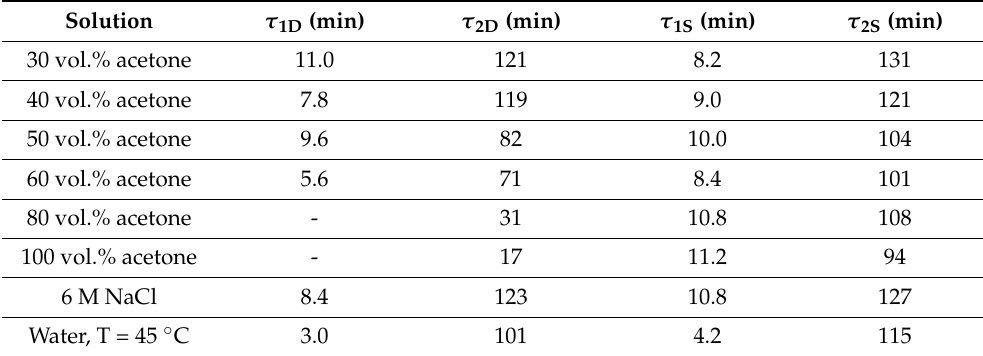
Table 2. Characteristic time parameters fitted using Equation (1) from deswelling curves in Figure 9 ( τ 1D , τ 2D ) and from swelling curves in Figure 10 ( τ 1S , τ 2S ). Solution τ 1D